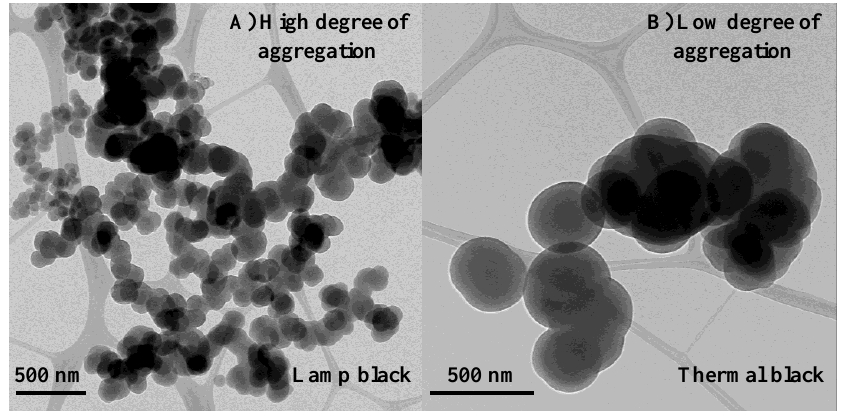
Figure 4 . TEM images contrasting a ( A ) high and a ( B ) low degree of aggregation in the different carbon blacks.